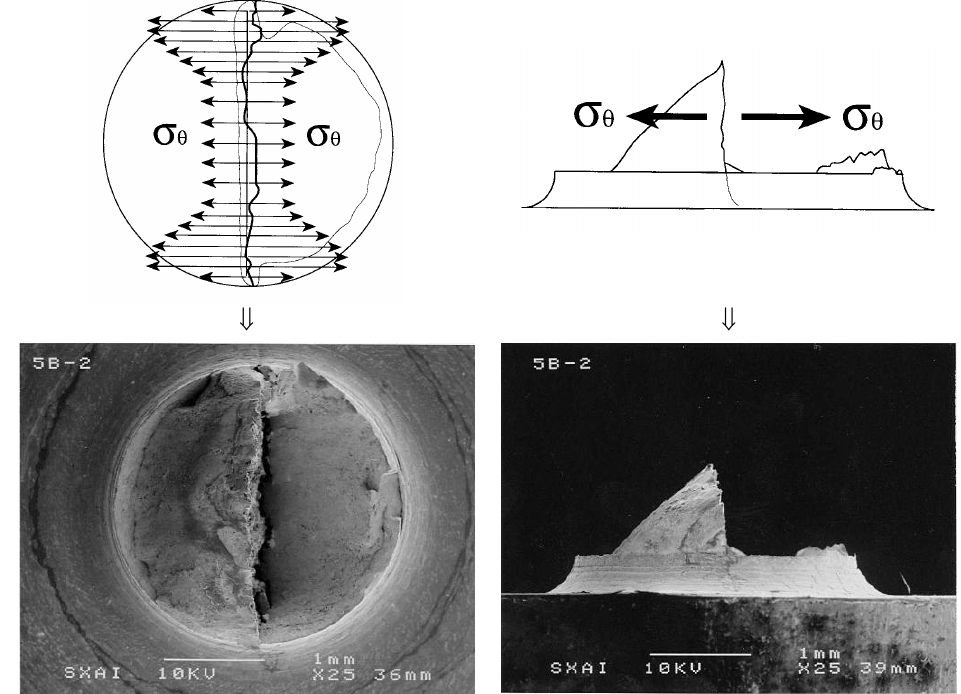
Figure 14. Distribution of the hoop stress along the net section of the sample ( up ) and its consequence on the fracture behaviour ( down ): front and side view. Sample 5B: wire after five drawing passes and notch B with the highest triaxiality level.